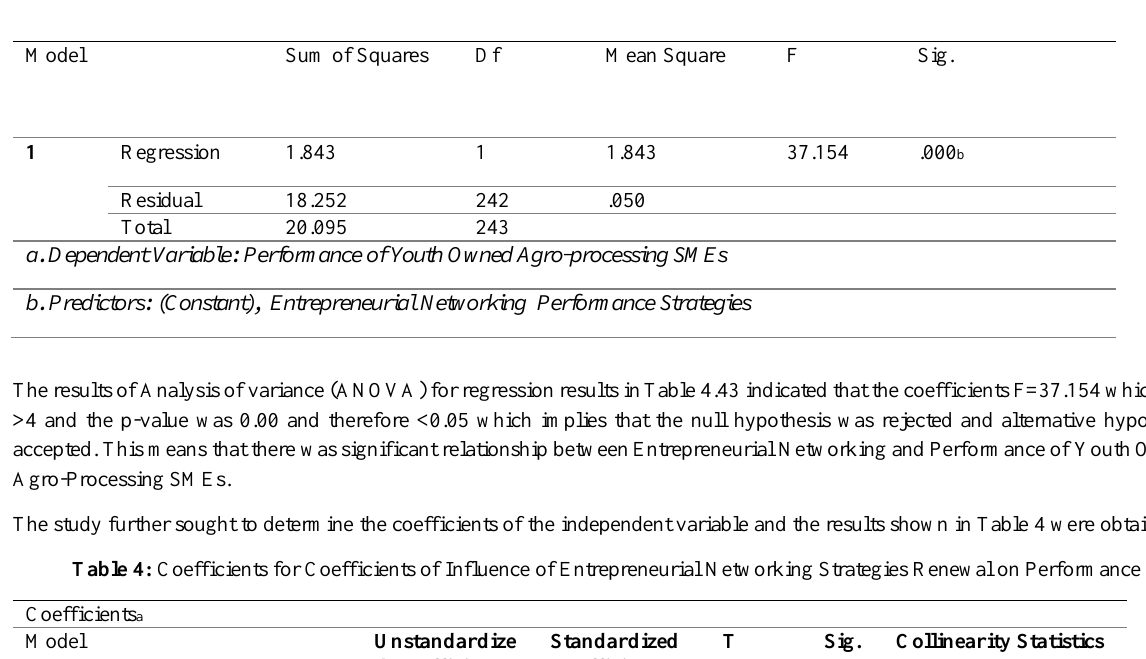
Table 3: ANOVA of Influence of Entrepreneurial Networking Strategies Renewal on Performance